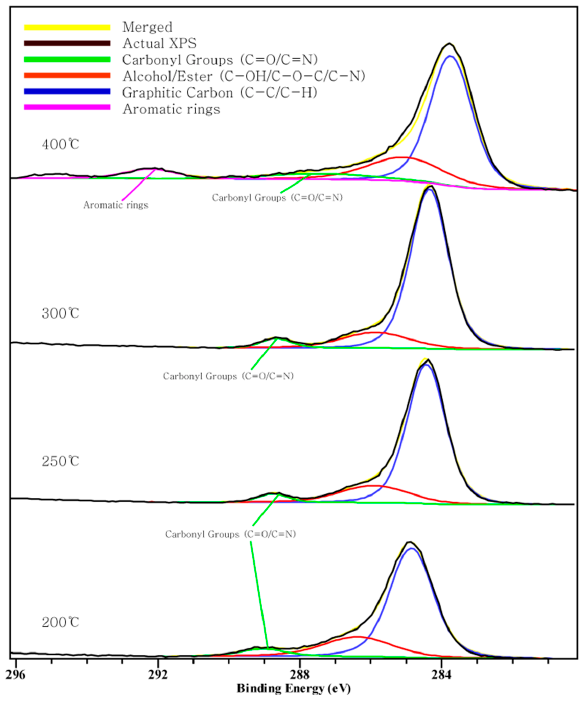
Figure 2. Carbon 1s X-ray photoelectron spectroscopy (XPS) spectra.